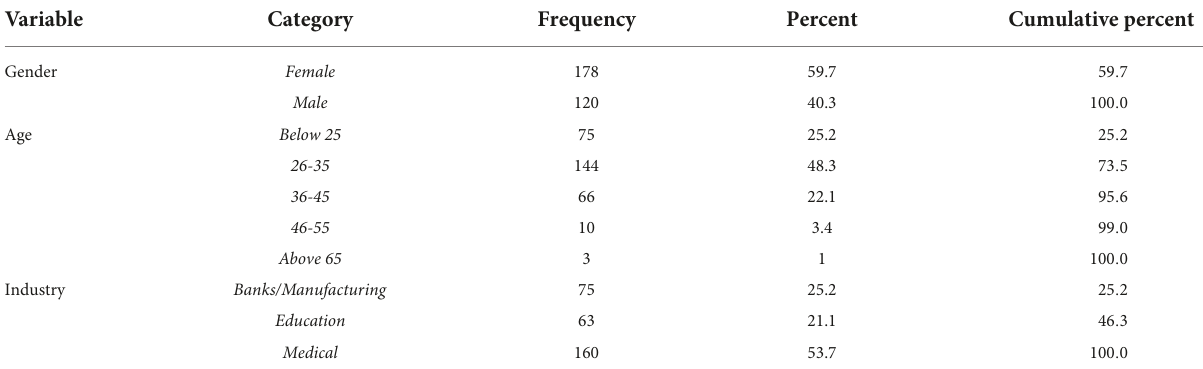
TABLE 1 Descriptive